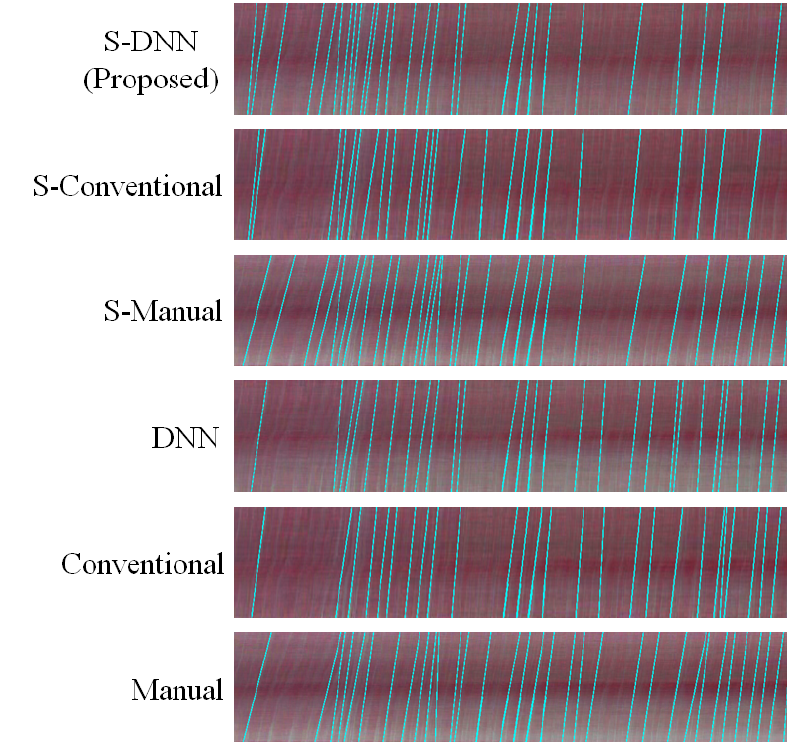
Figure A6. Events reconstructed from event counting using various methods for capillary